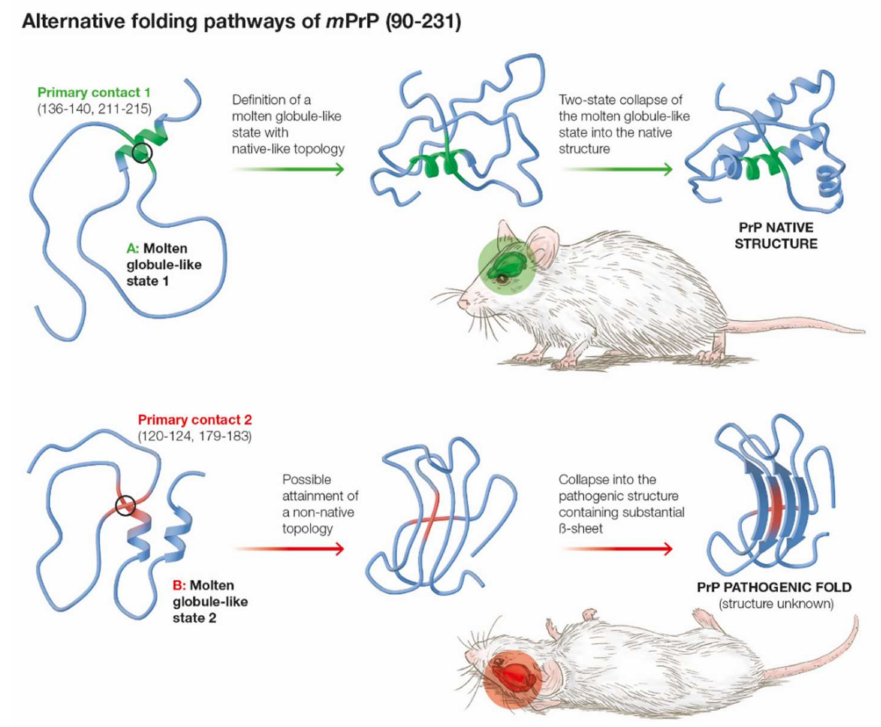
Figure 4. The alternative folding pathways with the less populated one possibly leading to pathogen- esis. The schematic representation of the pathogenic topology and final fold is